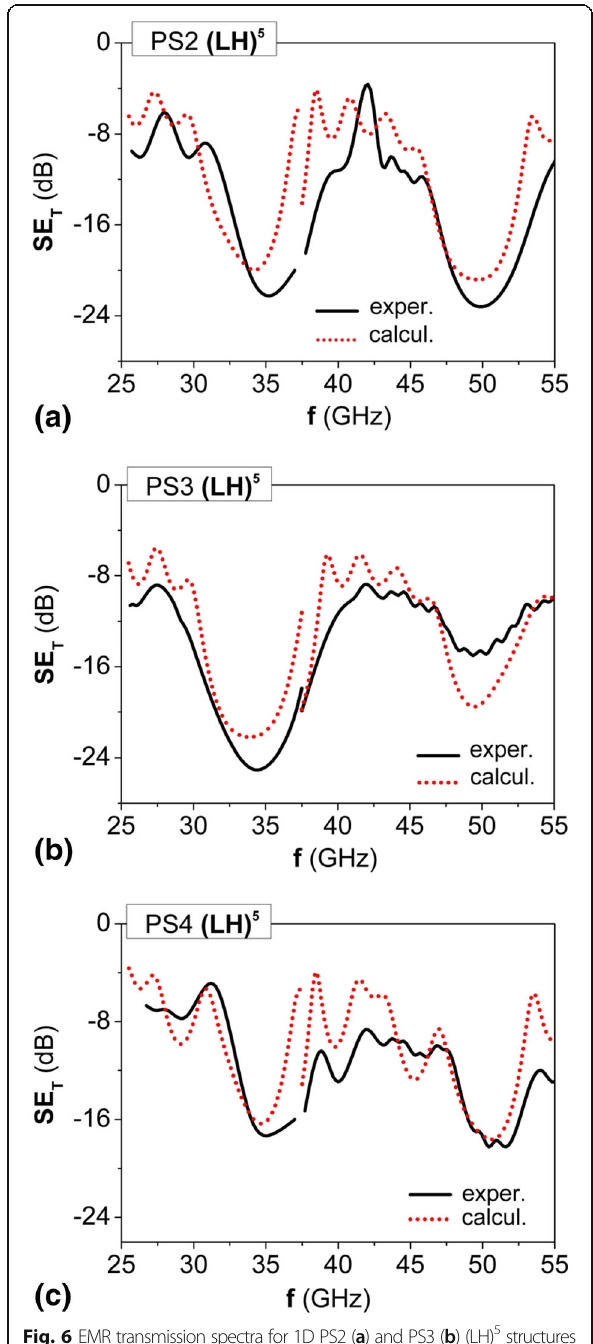
Fig. 6 EMR transmission spectra for 1D PS2 ( a ) and PS3 ( b ) (LH) 5 structures which consist of five epoxy layers L285, which alter with composite layers 5 wt.%GNP/L285 with various thickness of composite layers; ( c ) photonic structure PS4 with one magnetic M-layer; solid lines — experimental data, dotted lines — calculation at parameters listed in Tables 1 and